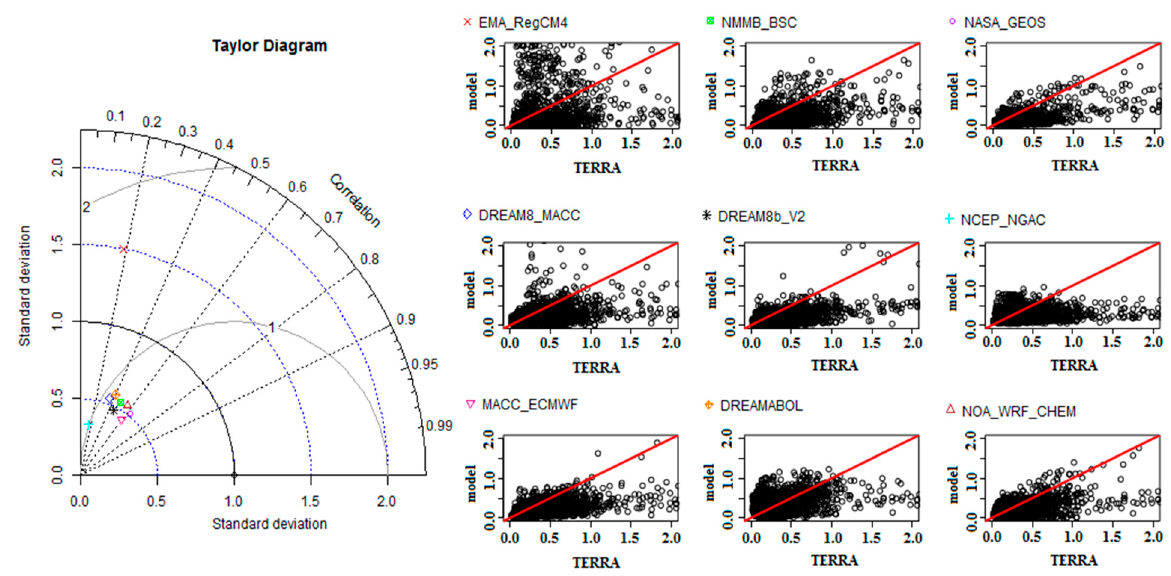
Figure 10. Taylor diagram and scatter plots of AOD values from model outputs and Terra-MODIS observations over the Middle East during pre-frontal dust storms.